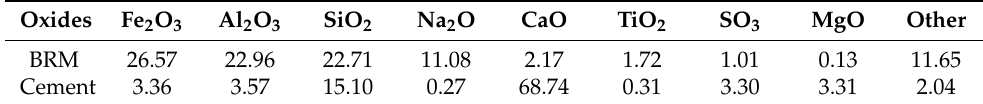
Table 1. The chemical constituents of BRM and cement (wt%).